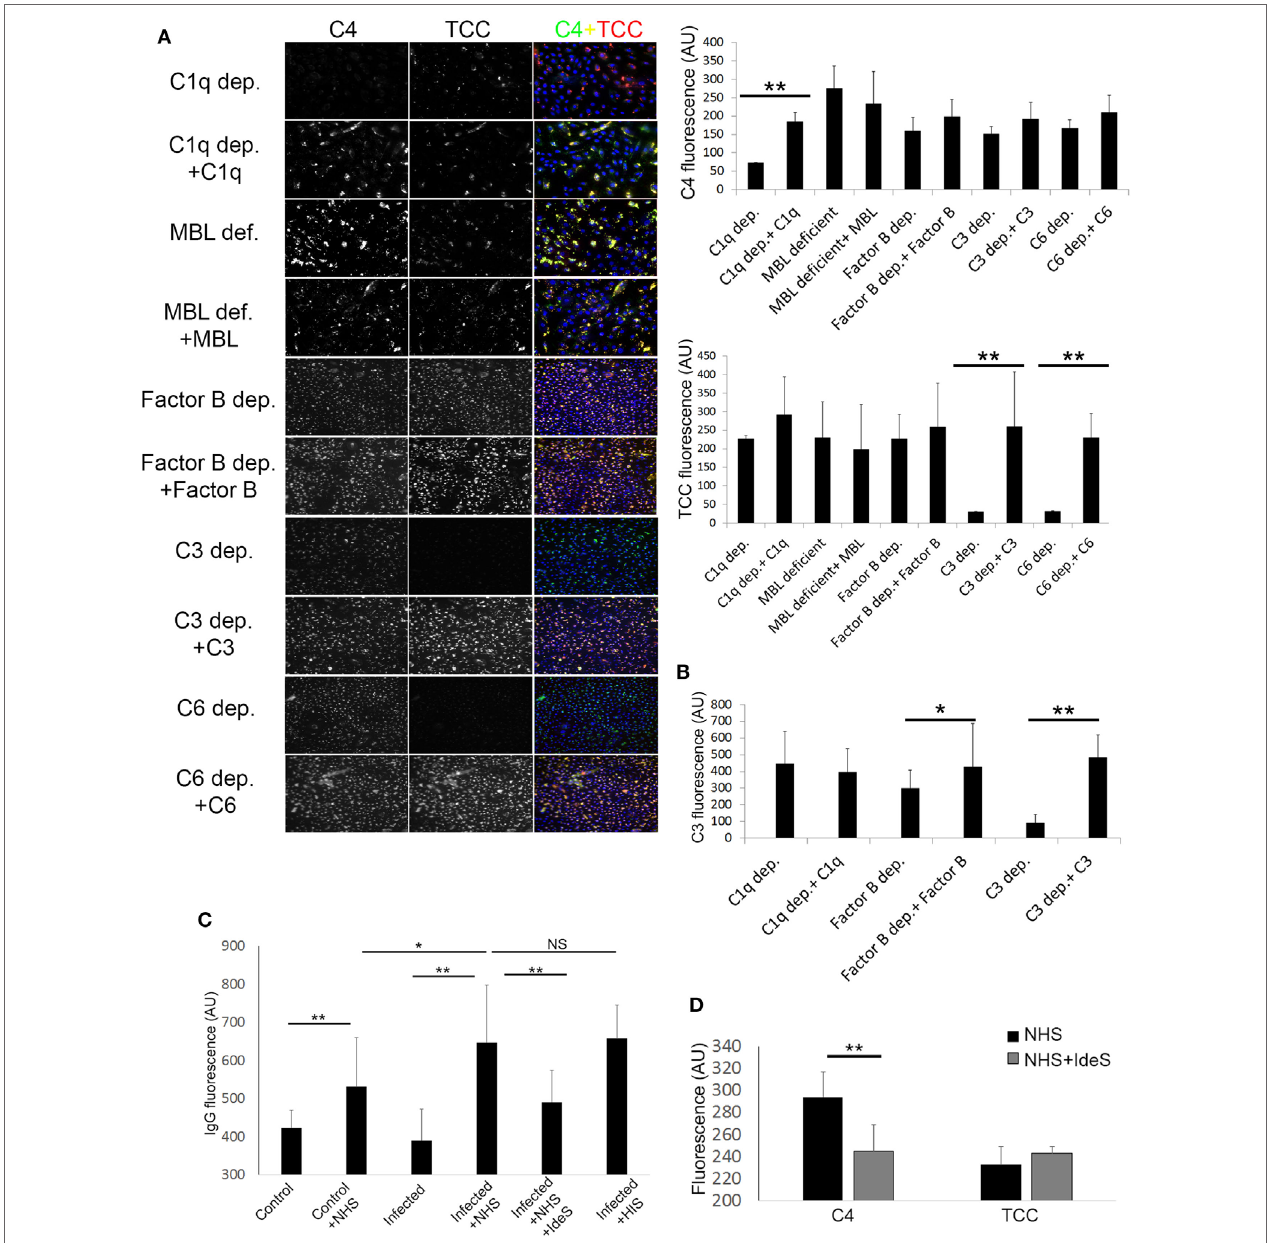
FigUre 3 | Pathways involved in complement activation induced by Keratinocytes with persistent intracellular Staphylococcus aureus . (a) Infected keratinocytes were incubated with depleted or deficient sera along with respective reconstitution proteins as a source of complement, then stained for component 4 (C4) and terminal complement complex (TCC). Immunofluorescence (IF) representative images are shown in the left panel along with quantification on the right. (B) IF of C3 was quantified in different depleted and reconstituted sera to confirm participation of the alternative pathway. (c) IF of IgG was quantified using anti human IgG antibodies, binding of IgG was found to be increased in infected keratinocytes incubated with normal human serum (NHS) or HIS. Treatment of NHS with IdeS significantly decreased IgG binding. (D) IF C4 and TCC were quantified in infected keratinocytes incubated with NHS or IdeS treated